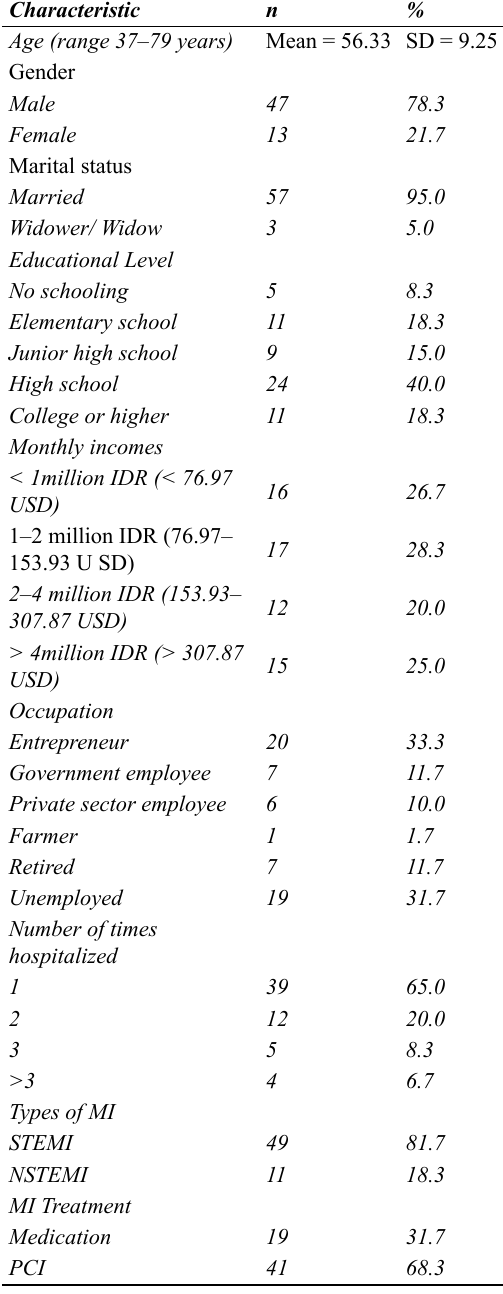
Frequency, percentage, means, and standard deviations of the patients’ demographic